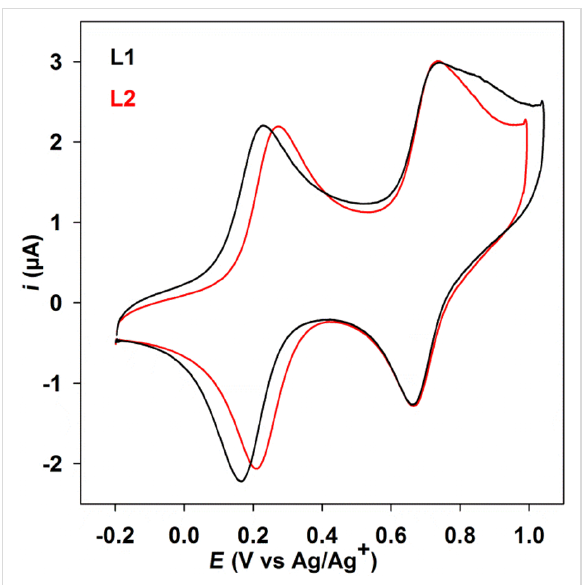
Figure 6: Cyclic voltammograms of ligands L1 and L2 (2 × 10 − 5 M) in CH 2 Cl 2 /CH 3 CN (9:1, v/v) at 100 mV·s − 1 on a glassy carbon electrode with n- Bu 4 NPF 6 (0.1 M).